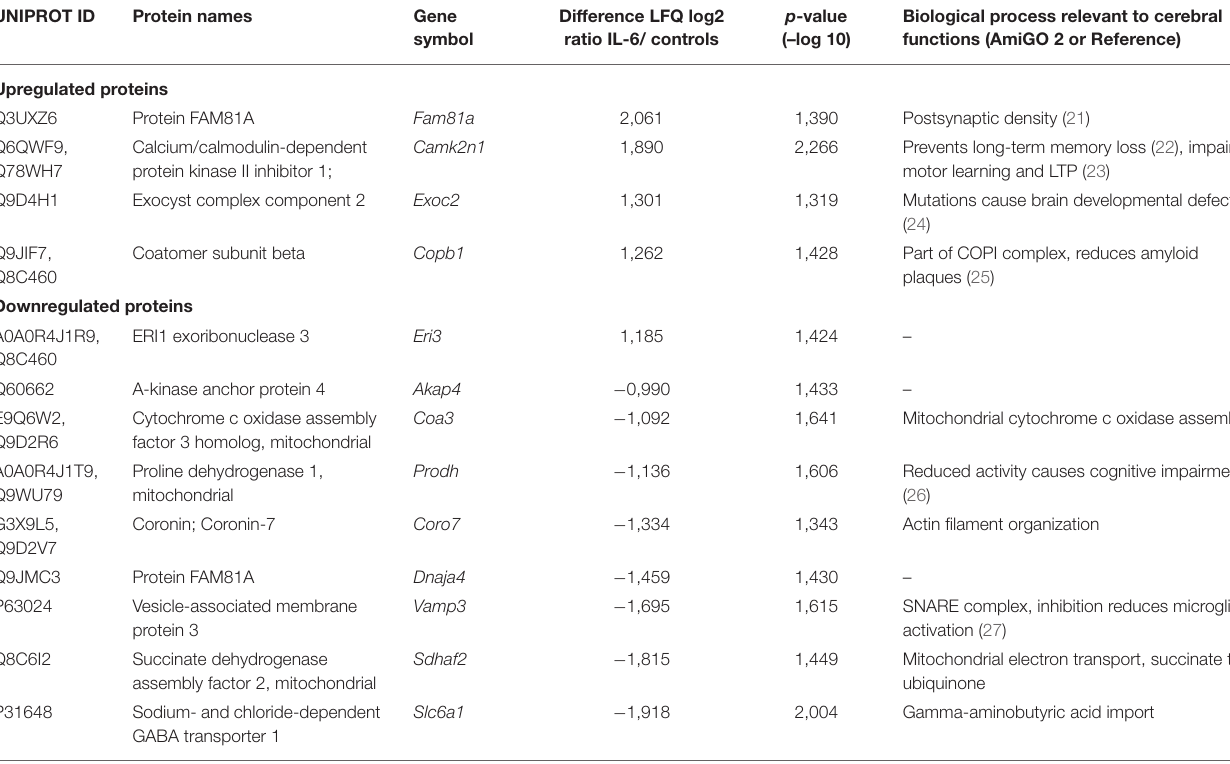
TABLE 2 | IL-6 dependent protein regulations in the contralateral motor cortex * . UNIPROT